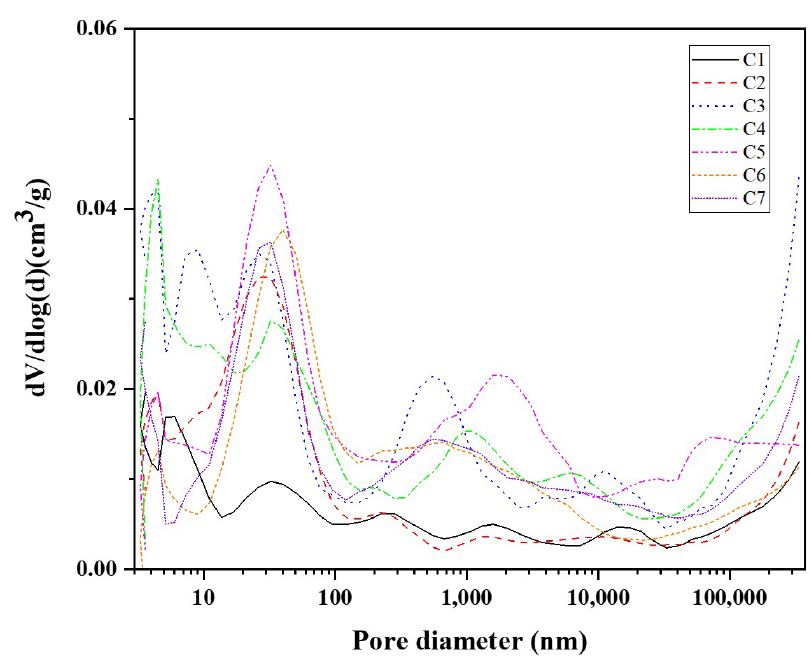
Figure 7. Pore size distribution in concrete.